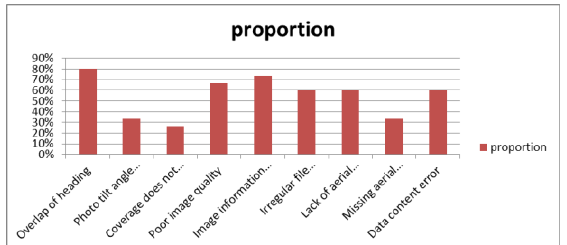
Figure 4 . 15 project case quality error and omission ratio statistics